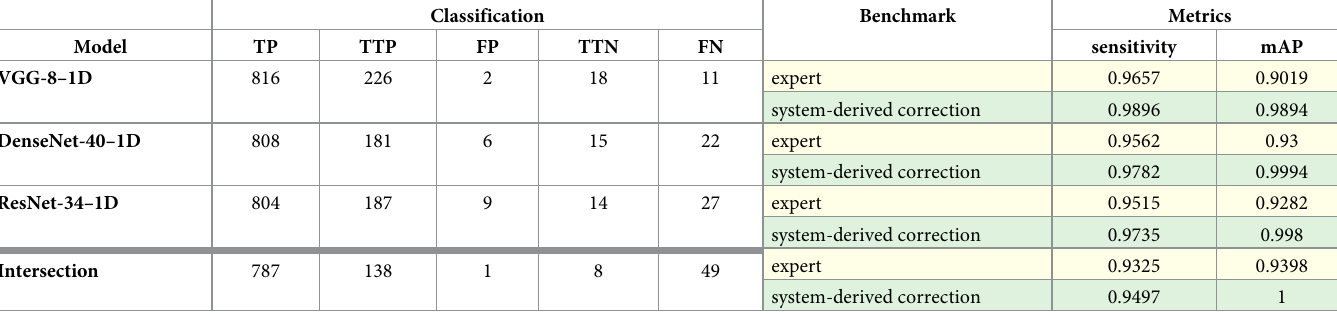
Table 3. Evaluation (1) of the results of stage 2 analysis of testing GC-MS samples.